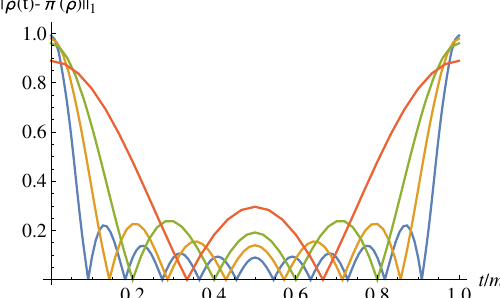
FIG. 4. Numerical simulations of the dephasing map that is induced by the noisy operation Eq. (9) for continuous time and system dimensions d ¼ m 2 ¼ 9 , 25, 49, 121 (red, green, yellow, blue lines). Shown is the trace-norm distance between the time- evolved state ρ ð t Þ and the pinched state π ð ρ Þ as a function of rescaled time t=m . The initial state is a maximally coherent state ffiffiffi P p d i i . The graph shows that, while for integer times ð 1 = Þ i j (with respect to the bath dimension) the dephasing is always exact, for noninteger times the deviation from exact dephasing becomes small with increasing dimension. The numerically obtained deviation at t=m ¼ 0 . 5 seems compatible with a scaling ffiffiffi p d as 1 =m ¼ 1 = , but we leave open to derive the exact scaling